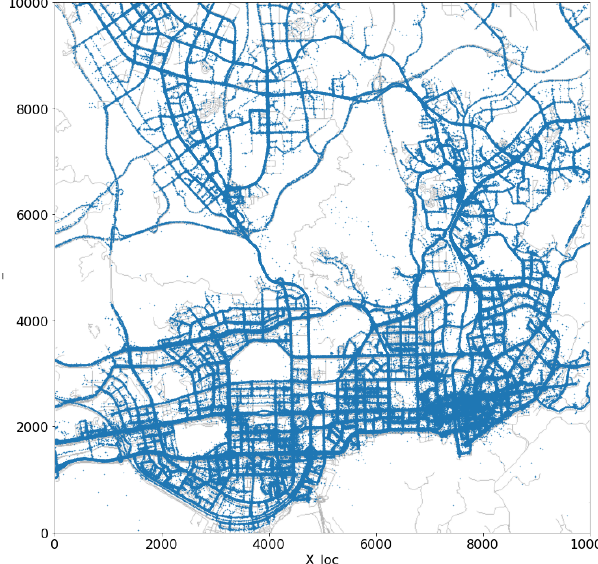
Figure 5. Sampled locations of moving objects in Shenzhen City road network.